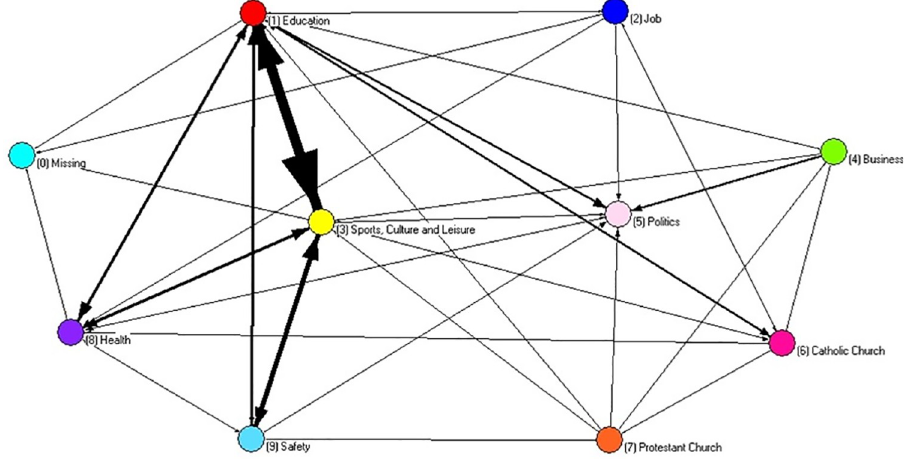
Fig 3. Digraph of alpha community nodes have been collapsed by